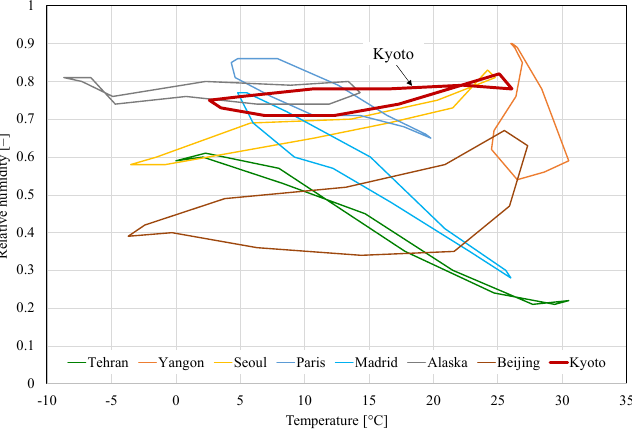
Figure 1. Comparison of climatic conditions in Japan and other countries [18].